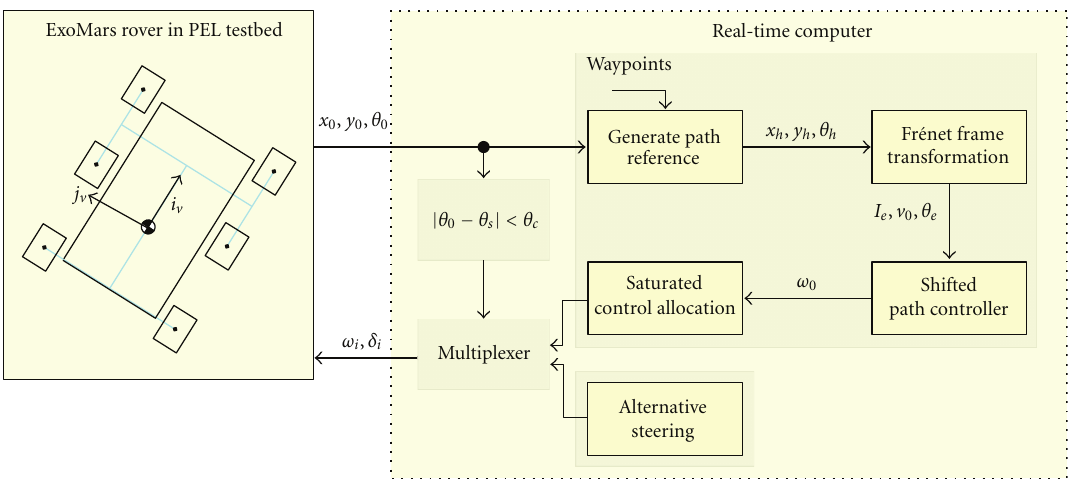
Figure 14: Block diagram of the path following control in faulty mode.